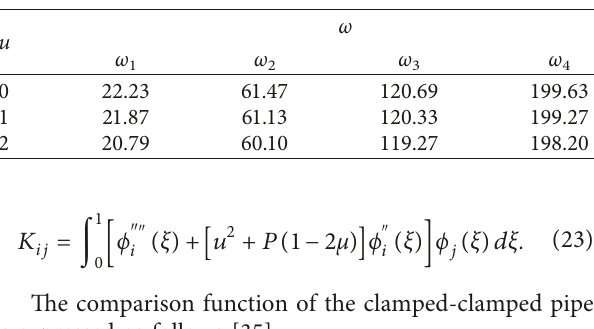
Figure 17: The deflections of the clamped-clamped pipe having different fluid velocities: (a) u � 0; (b) u � 1; (c) u � 2. Table 5: The first four dimensionless natural frequencies of the clamped-clamped